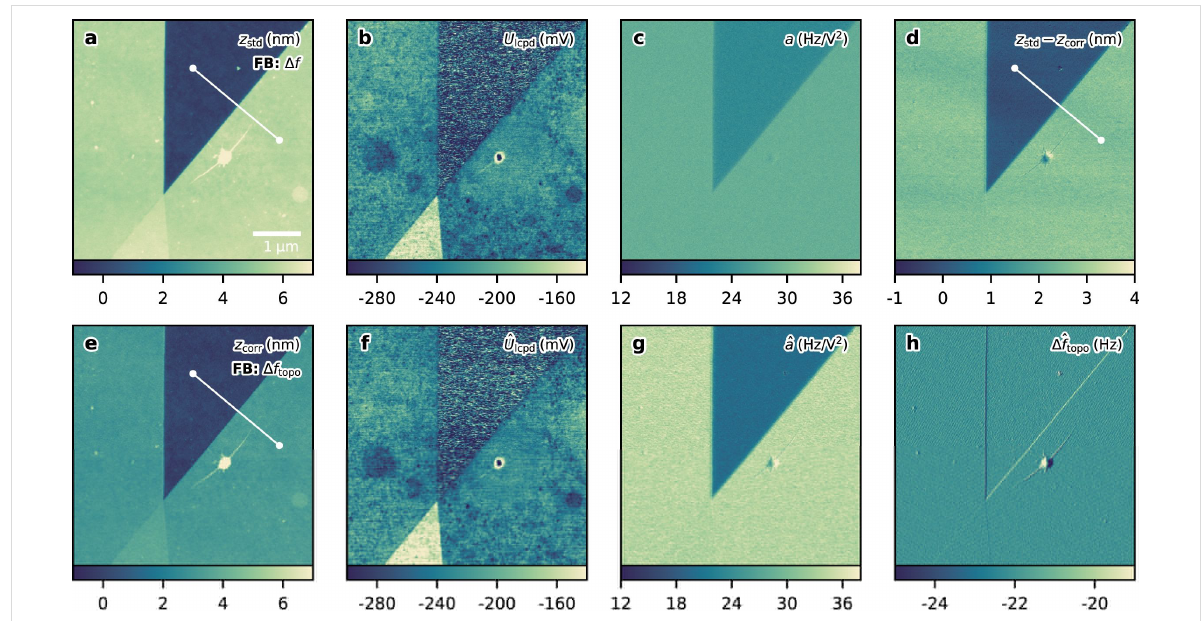
Figure 4: Comparison of standard single-scan FM-KFM and closed-loop TD-KFM of two overlapping graphene flakes. (a–c) Topography, U lcpd , and coefficient a obtained from a FM-KFM scan with direct sideband detection. (e–h) Topography, , coefficient , and obtained by TD-KFM. The estimated topography-induced frequency shift was used as topography feedback here. (d) Height difference between the TD-KFM and standard FM-KFM scan. The cross sections indicated by the white lines are shown below in Figure 5. Parameters FM-KFM: Δ f set = − 65 Hz, U ac = 2 V, f m = 1.5 kHz, PLL bandwidth: 500 Hz; TD-KFM: = − 22 Hz, U ac = 2 V, f m = 253 Hz, f s = 3.6 kHz, PLL bandwidth: 1 kHz, R th = 1.66 × 10 − 3 Hz 2 Hz − 1 , Q topo = 5 Hz 2 Hz, Q lcpd = 0.004 V 2 Hz, Q a = 5 Hz 2 V − 4 Hz; Detection noise R D ≪ R th is neglected here. Tip: